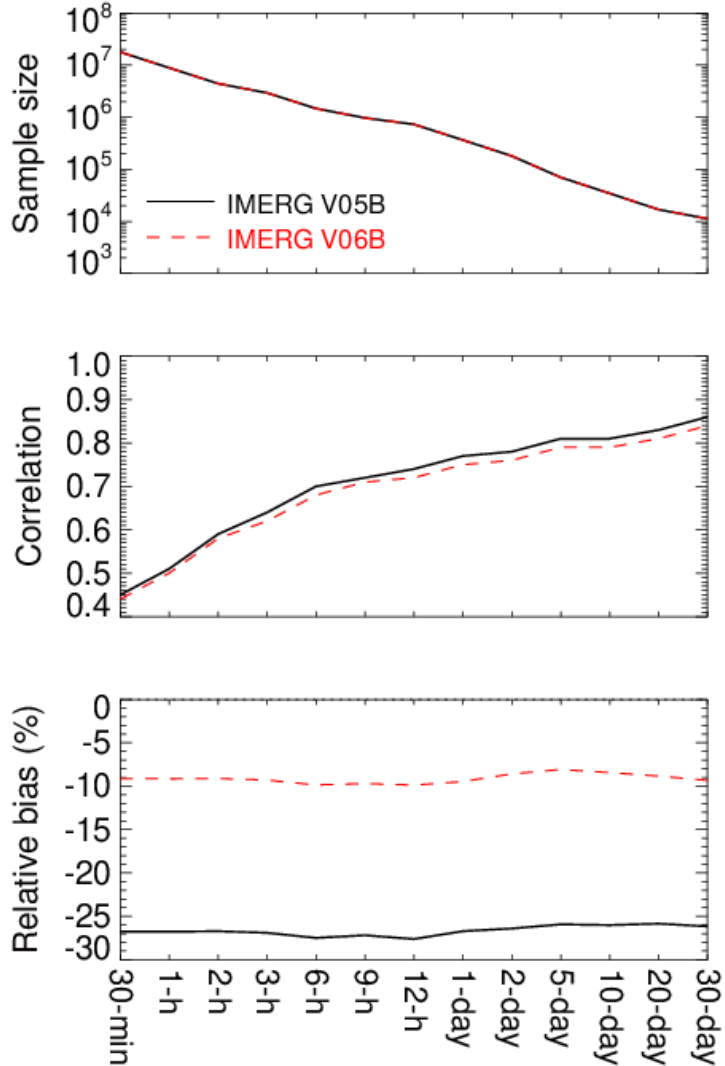
Figure 3. Comparisons of IMERG V05B and V06B with KPOL at 0.1° resolution and various time scales ranging from 30 min to 30 days over the period from April 2014 to June 2018. Number of matched pairs of IMERG V05B (V06B) and KPOL mean precipitation rate ( ≥ 0.0 mm h − 1 ) ( top ). Pearson correlation coefficient between IMERG V05B (V06B) and KPOL mean precipitation rates ( middle ). Relative bias for mean precipitation rate from IMERG V05B (V06B) with respect to KPOL mean precipitation rates ( bottom ).